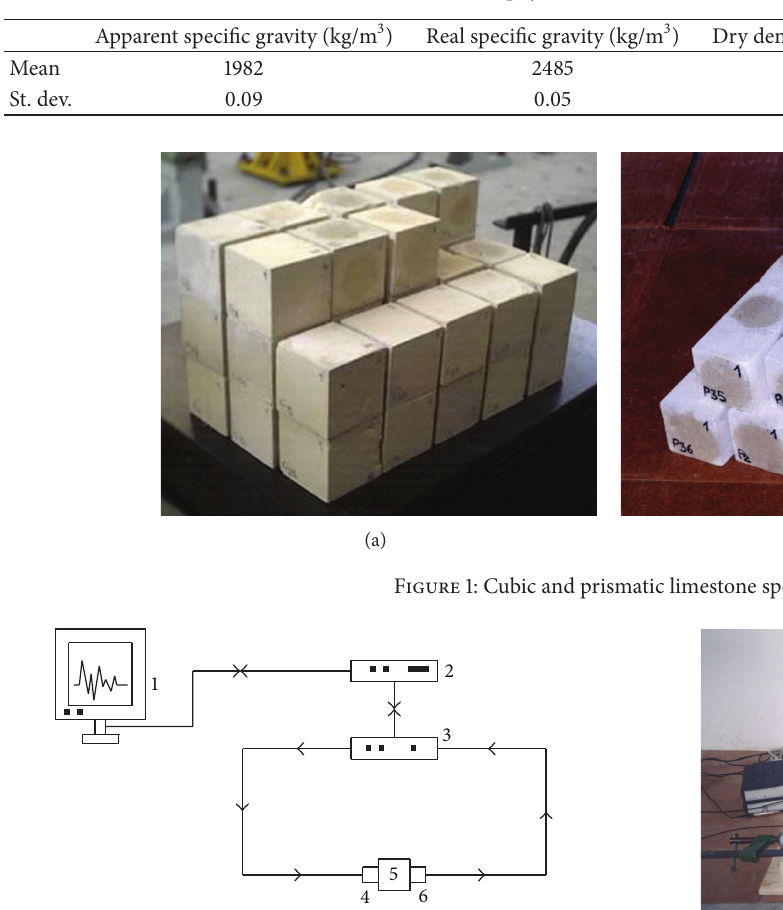
Table 1: Main physical characteristics of local limestone.